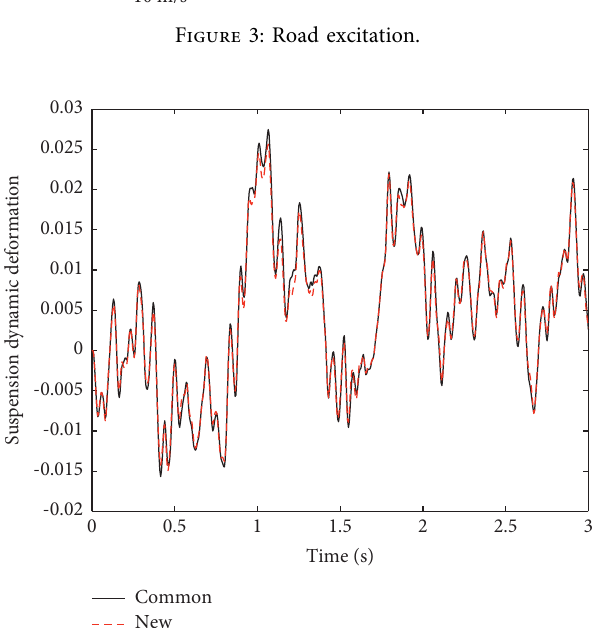
Figure 3: Road excitation.